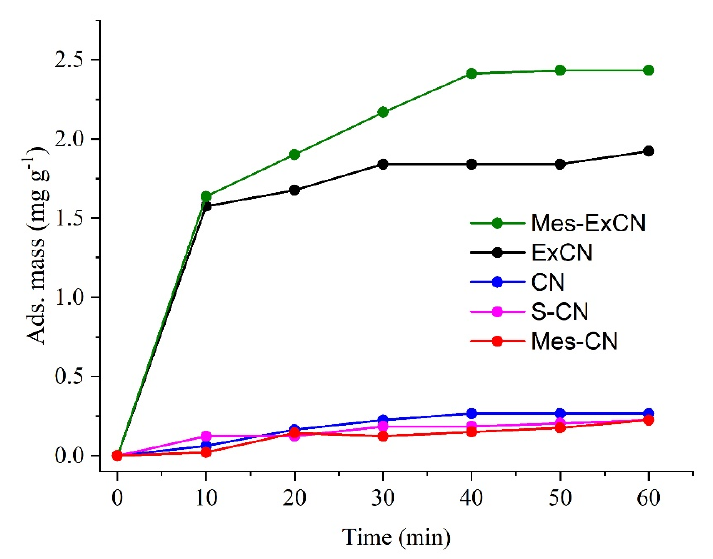
Figure 9. Adsorption of AO7 on CN-based nanomaterials depending on time.